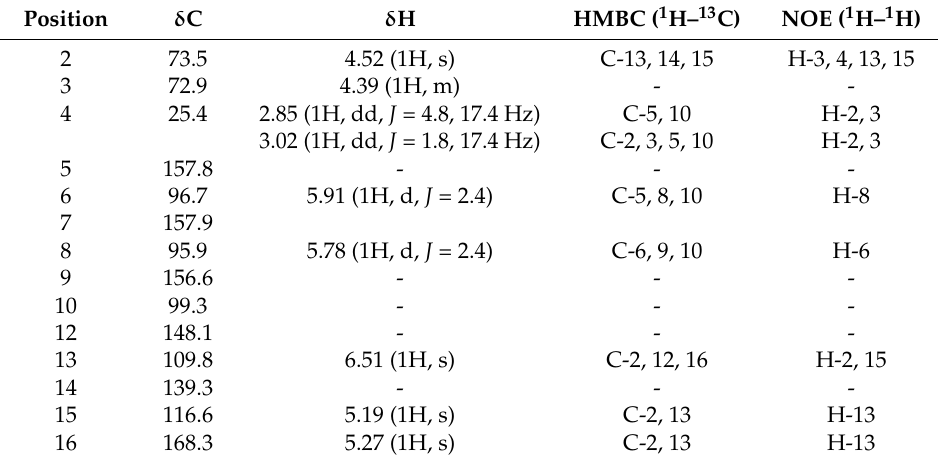
Figure 5. Chemical structure of 2D NMR correlations of compound 1 ( HMBC, 1H ‐ 1H COSY). Table 2. Nuclear Magnetic Resonance (NMR) data of compound 1 (in MeOD).